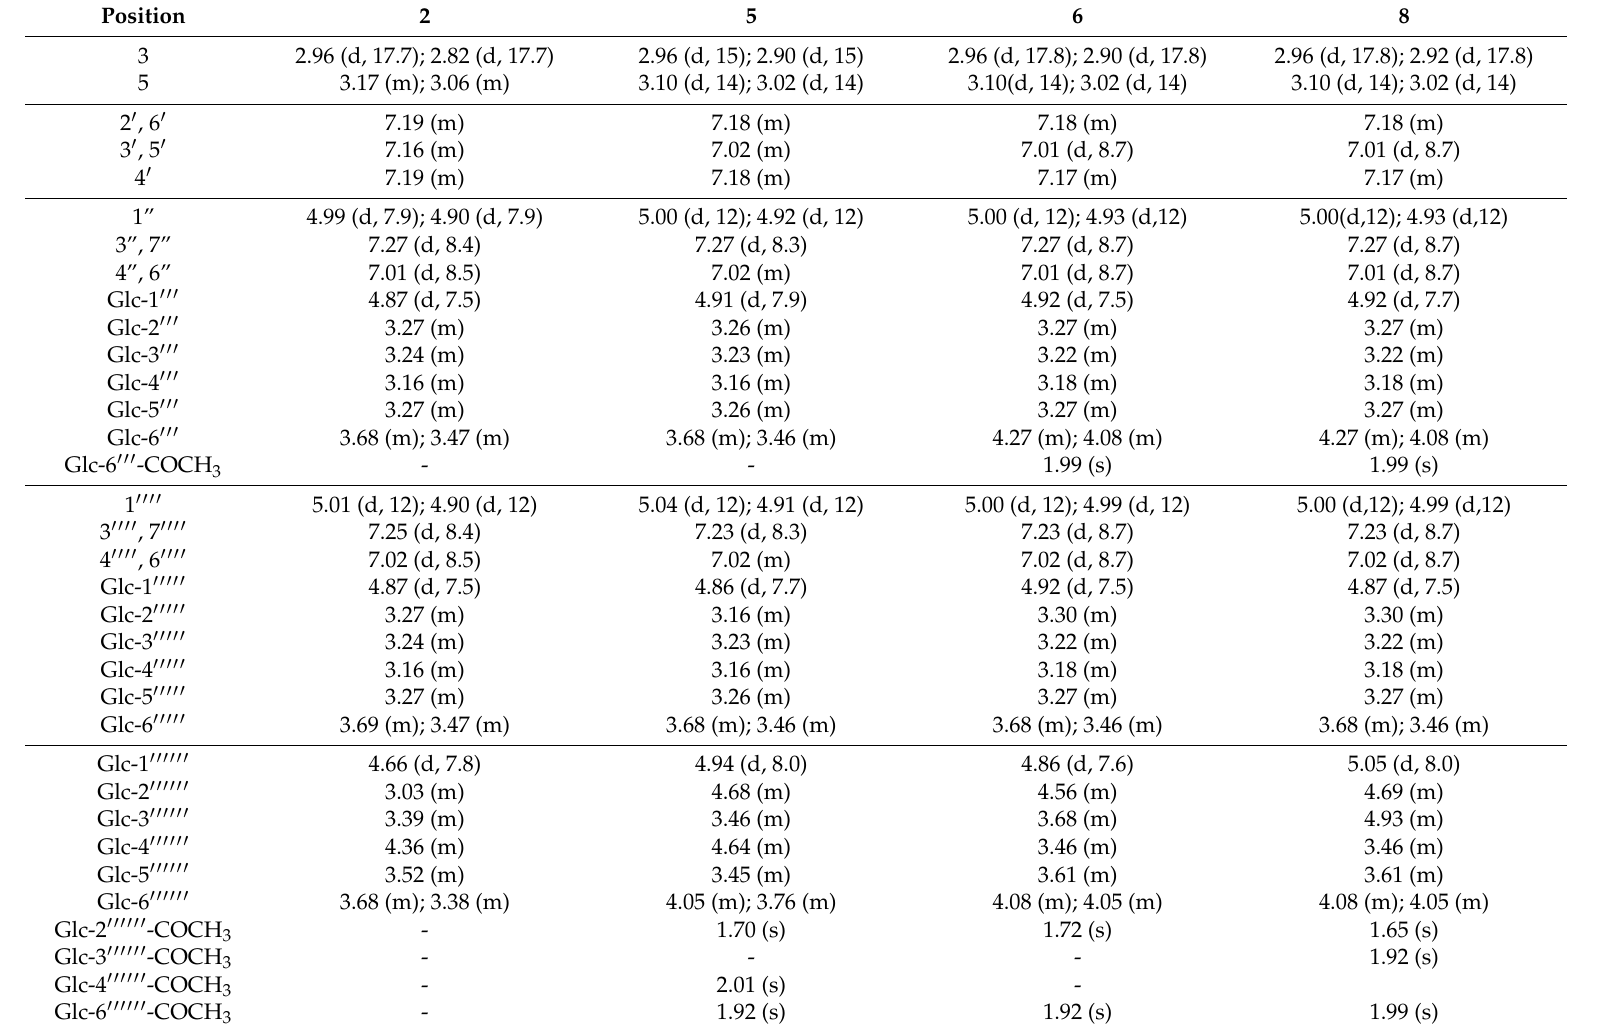
Table 1. 1 H nuclear magnetic resonance (NMR) data of four new compounds (700 MHz, DMSO-d6).